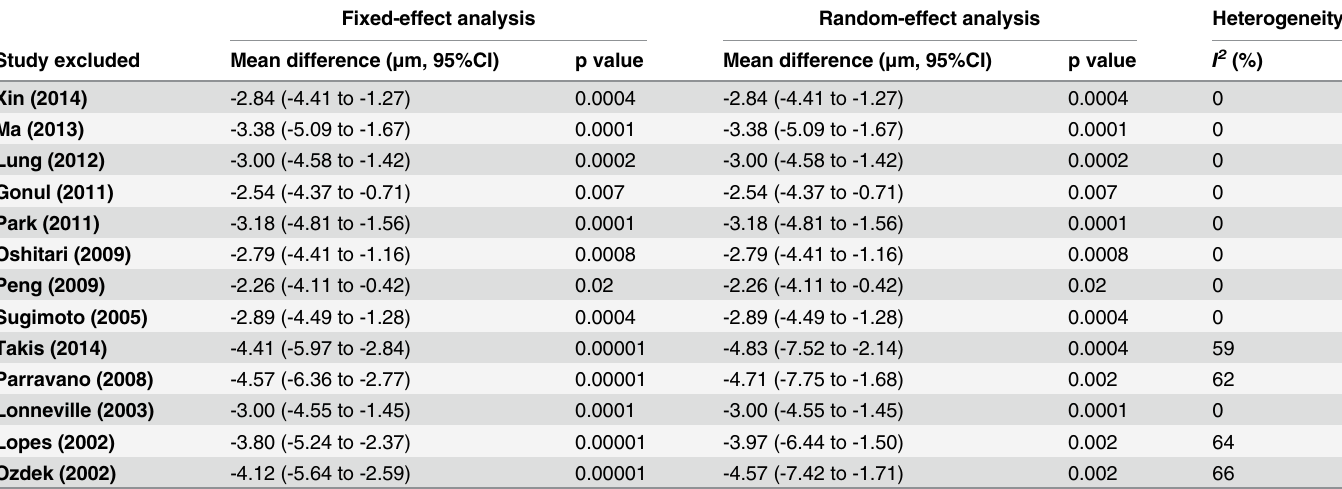
Table 2. Results of sensitivity